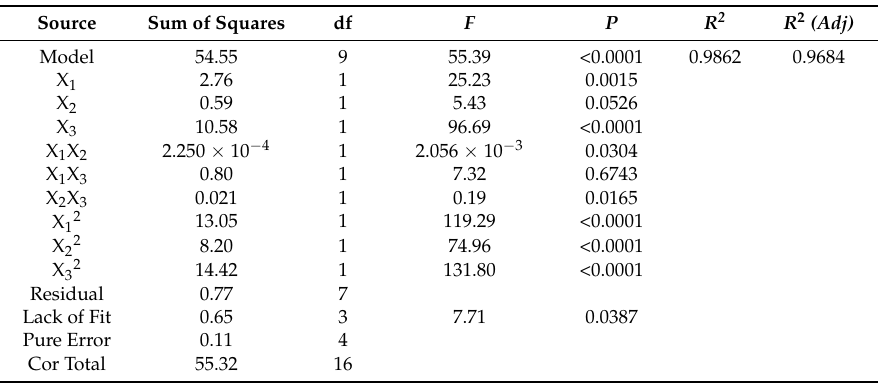
Table 1. ANOVA for the fitted quadratic polynomial model for total flavonoids